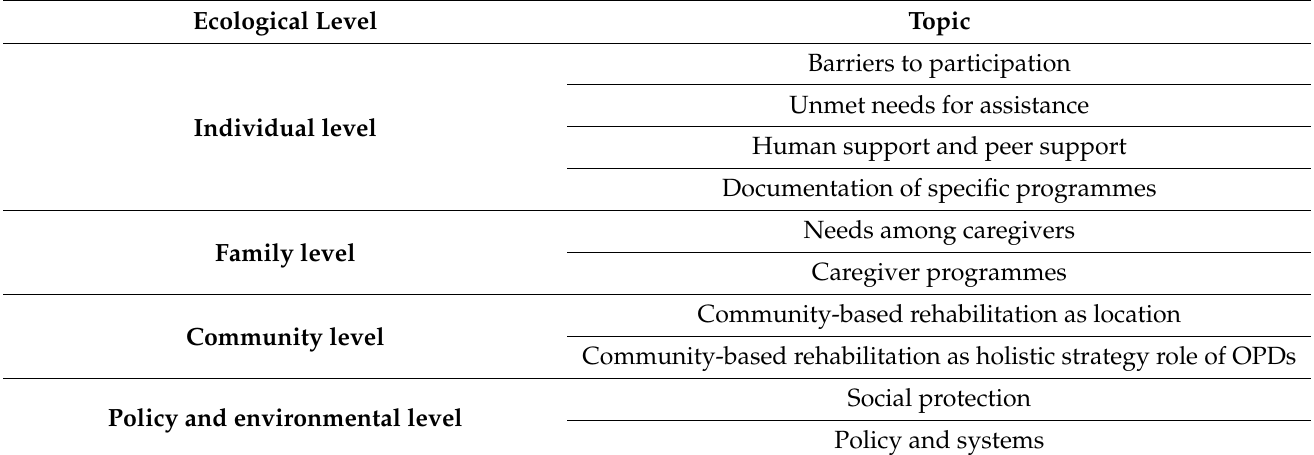
and quality of evidence. Table 2. Key topics covered in the